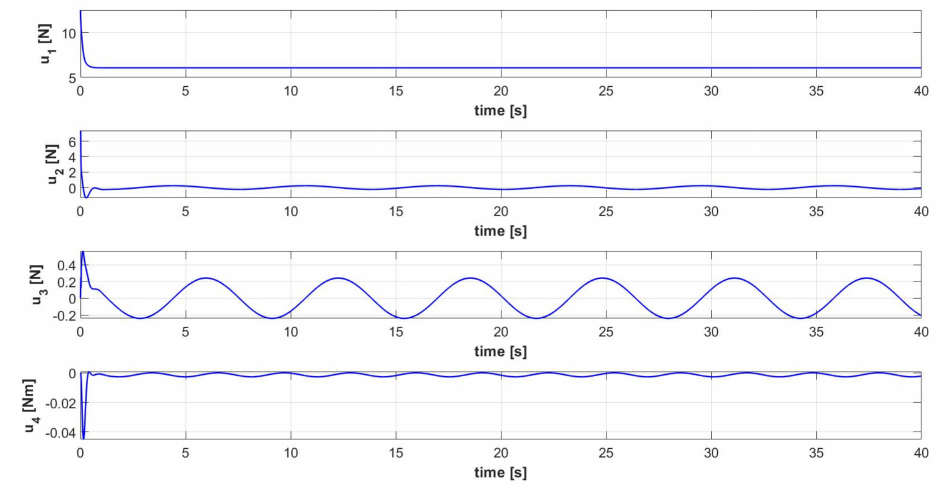
Figure 11. Control input signals [u 1 ( t ) , u 2 ( t ) , u 3 ( t ) , u 4 ( t ) ] of the controlled quadrotor system exe- cuting trajectory